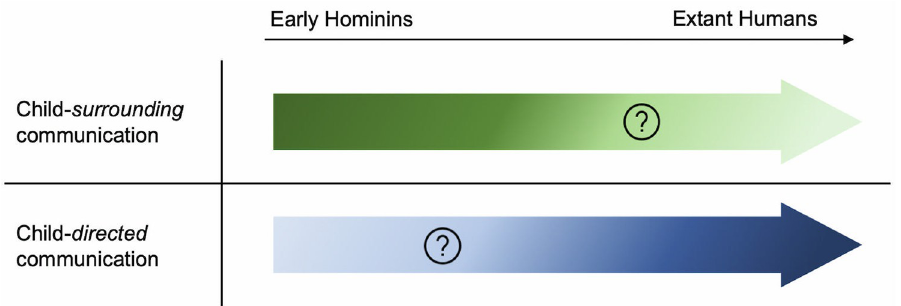
Fig 2. Transition of CSC to CDC. The transition of the importance of use of CSC to CDC. Darker color shows importance/presence and brighter color possible insignificance of CSC and CDC from early hominins to extant humans. CDC, child-directed communication; CSC, child-surrounding communication.